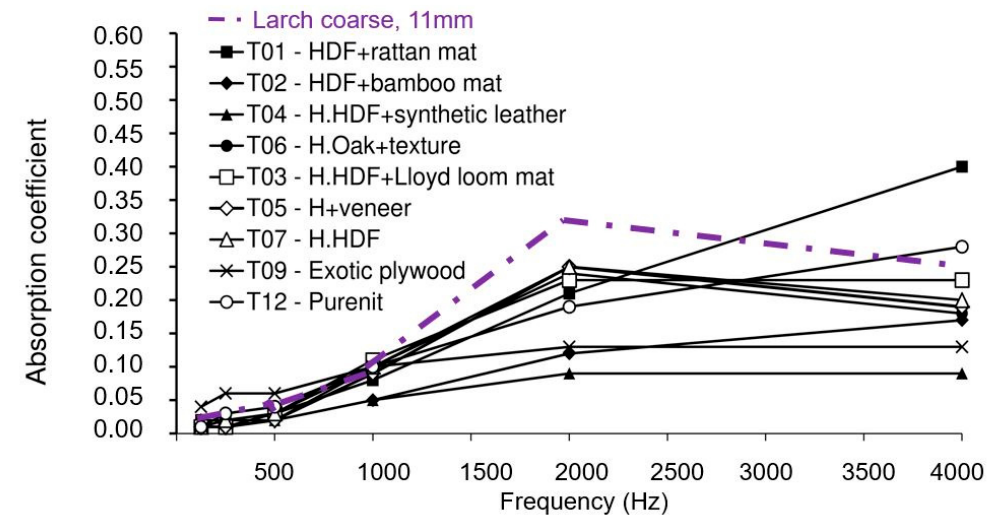
Figure 4. Dependence of the sound absorption coefficient on frequency for wood-based composites with a thickness 7.9 < x < 11 mm (after Smardzewski et al. [9]).